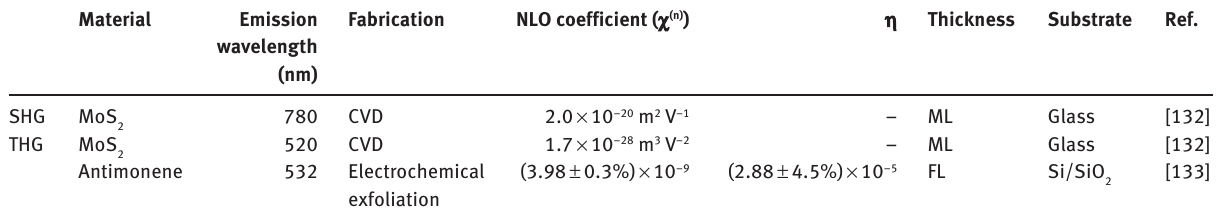
Table 4: NLO processes in 2D materials.